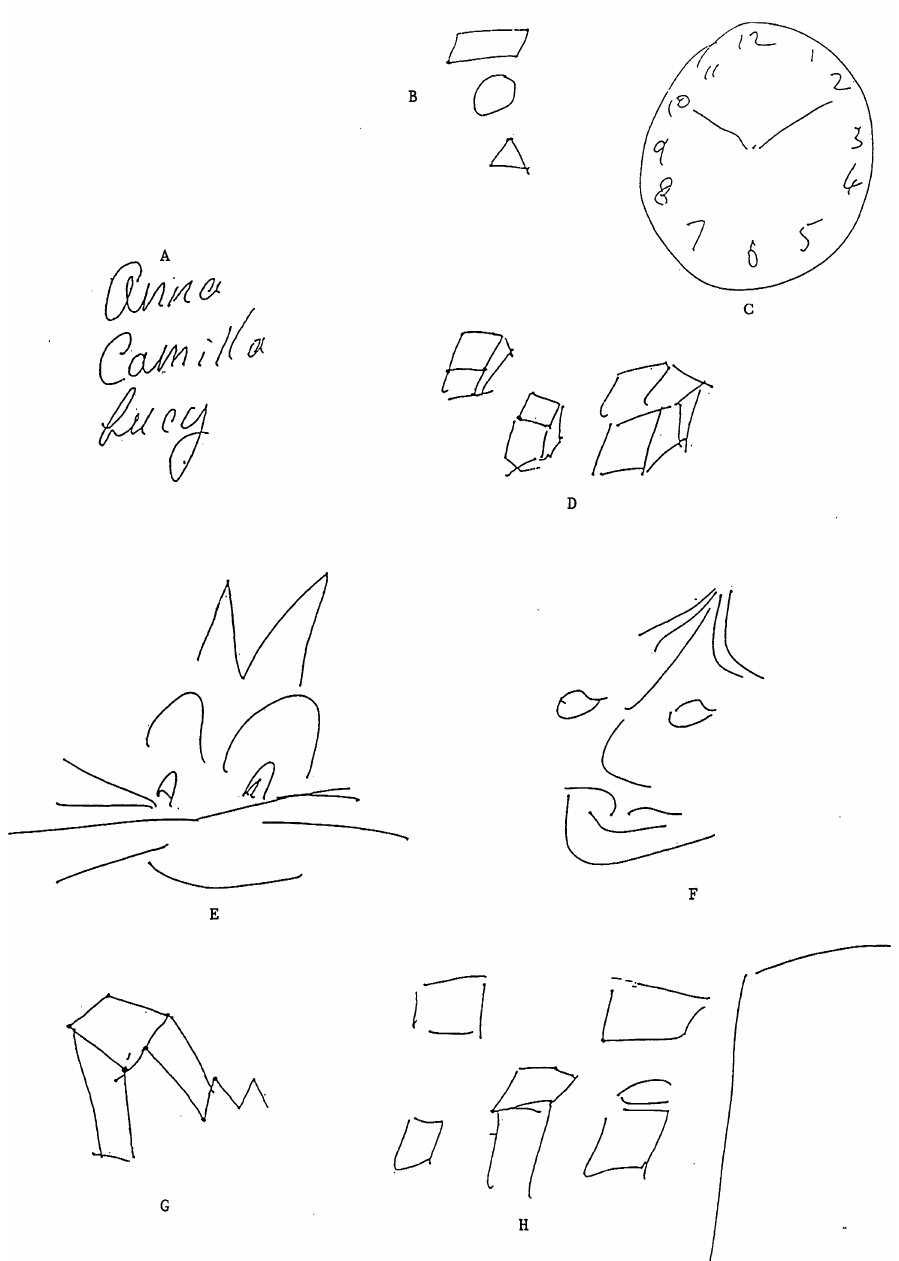
FIG. 2. MP's writing and drawing right handed (for full explanation see